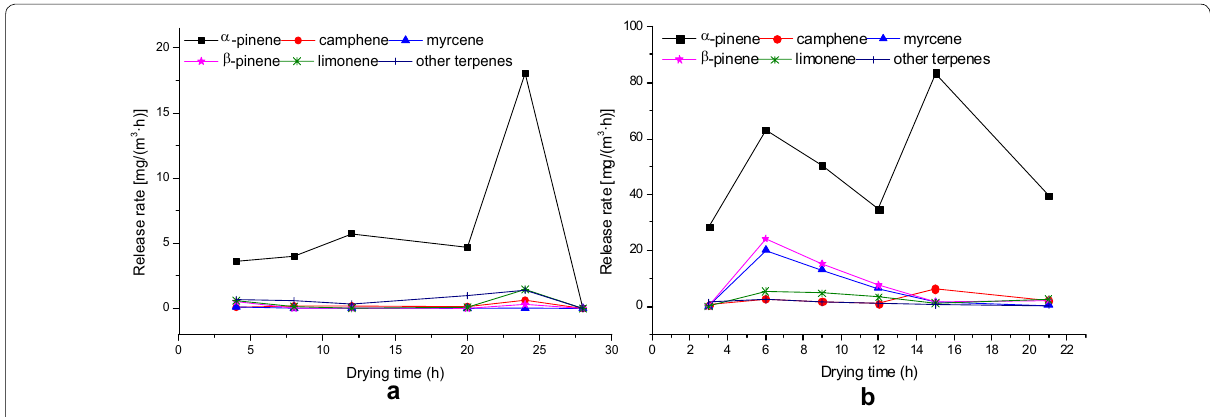
Fig. 3 Variations of release rate of terpenes during a conventional drying, and b high-temperature